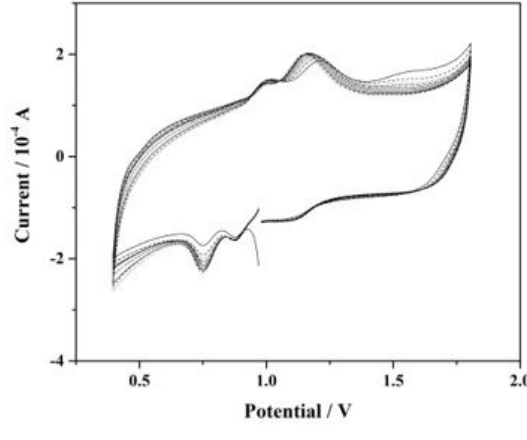
Figure 3: Continuous cyclic voltammograms obtained for the cell, Zn / IL based GPE /